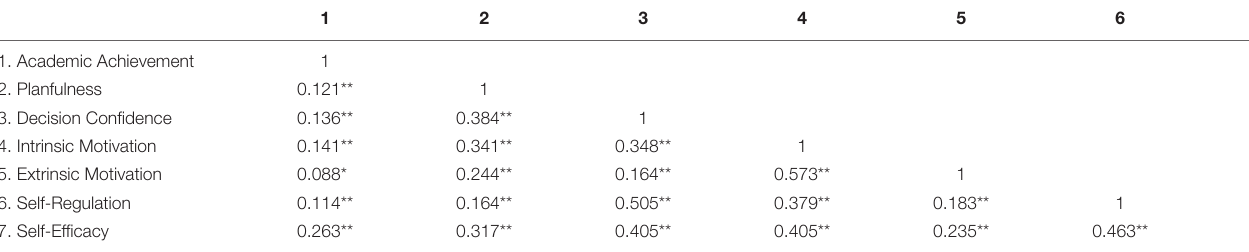
TABLE 8 | Correlations among the AFLQ Subscales with academic